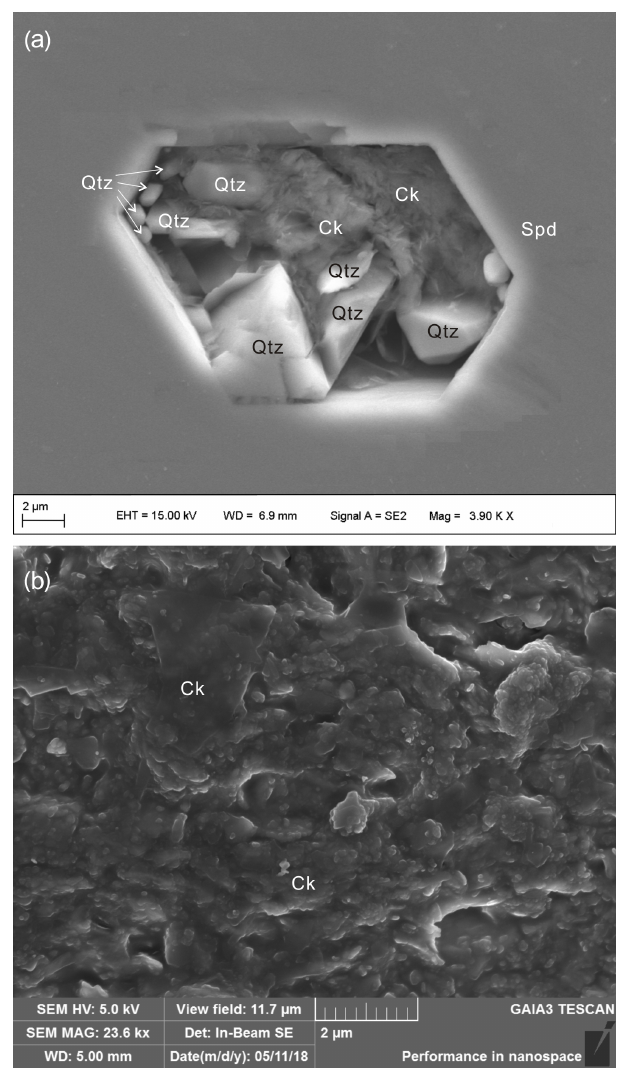
Figure 5. Two SEM images of cookeite crystals in one exposed crystal-rich inclusion hosted in spodumene from the Jiajika peg- matite. The SEM analysis conditions are shown, and the marked lengths are the entire scale bars. Spd – spodumene; Ck – cookeite; Qtz –